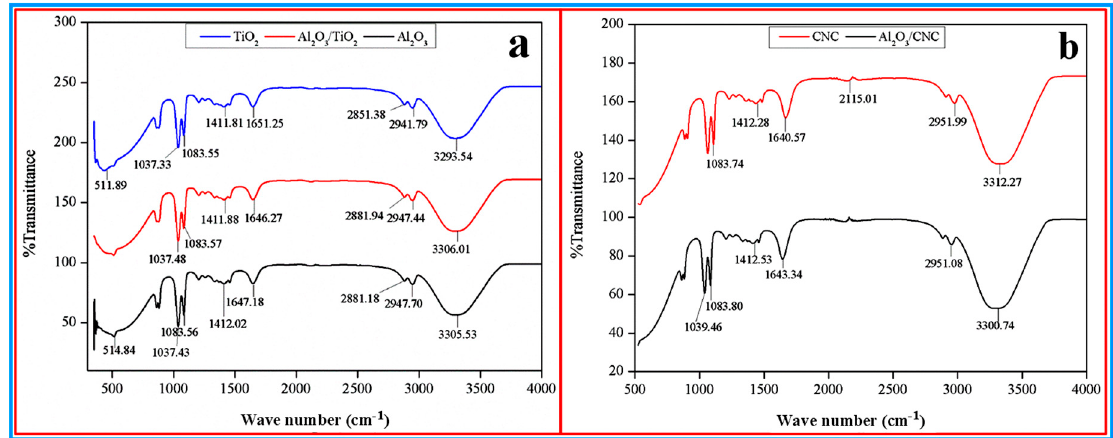
Figure 8. FTIR spectra of ( a ) TiO 2 , Al 2 O 3 , Al 2 O 3 / TiO 2 (hybrid) nanofluids, and ( b ) CNC mono and Al 2 O 3 /CNC hybrid nanofluid.